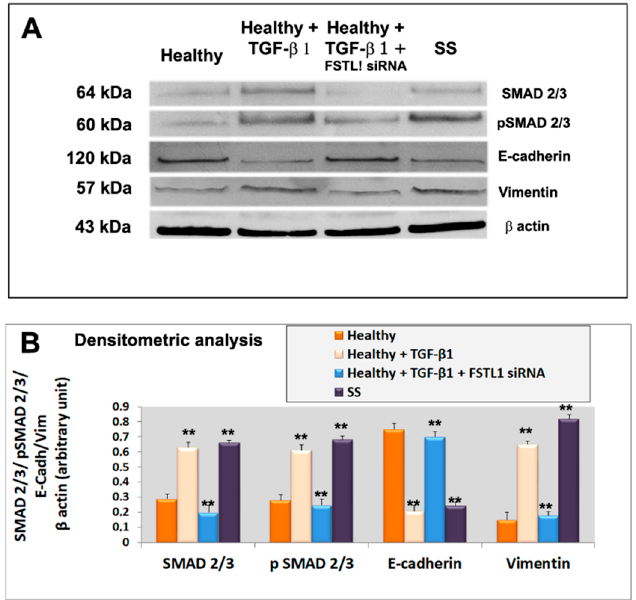
Figure 5. ( A ): representative Western blot analysis of E-cadherin, vimentin, total SMAD2/3 and P-SMAD2/3 proteins expression in healthy untreated control SGEC (lane 1), healthy SGEC treated with TGF- β 1 for 48 h (lane 2), cells transfected with FSTL1 siRNA and subsequently treated with TGF- β 1 for 48 h (lane 3). SS SGEC protein lysate was used as a positive control. For quantitative analysis banding densities were compared with test marker β -actin ( B ). Data are expressed as a significant change relative to the untreated control cells. Each bar represents the mean ± SE. **, p < 0.01. Each experiment was repeated three times.